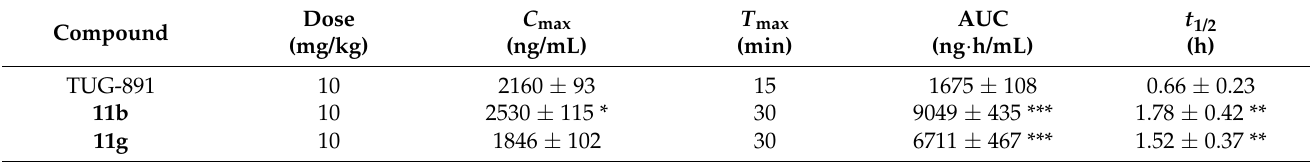
Table 3. Pharmacokinetic profiles of compound 11b , 11g , and TUG-891 in C57BL/6 mice a